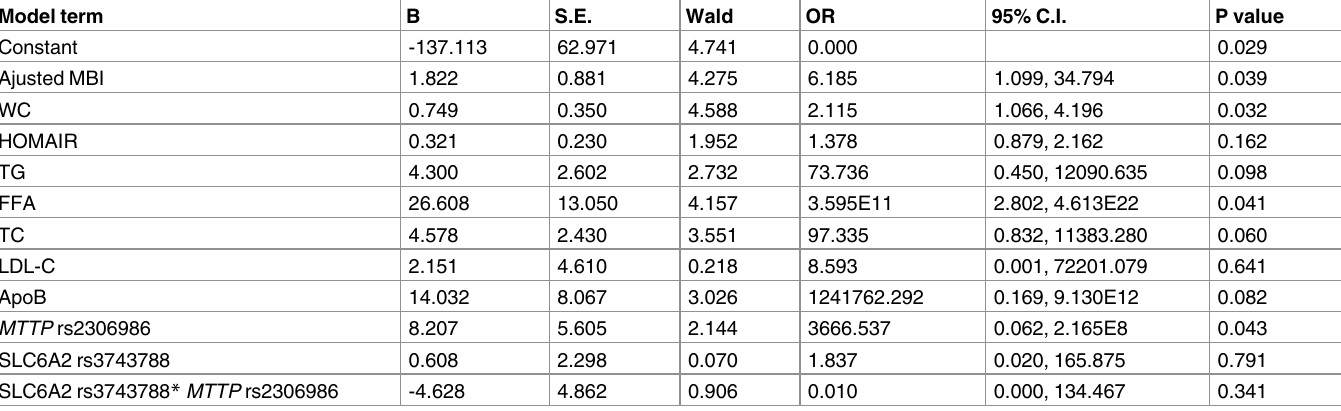
Table 5. Logistic regression for the two significant variants in subjects with and without NAFLD (subjects of Han Chinese ethnicity). Model